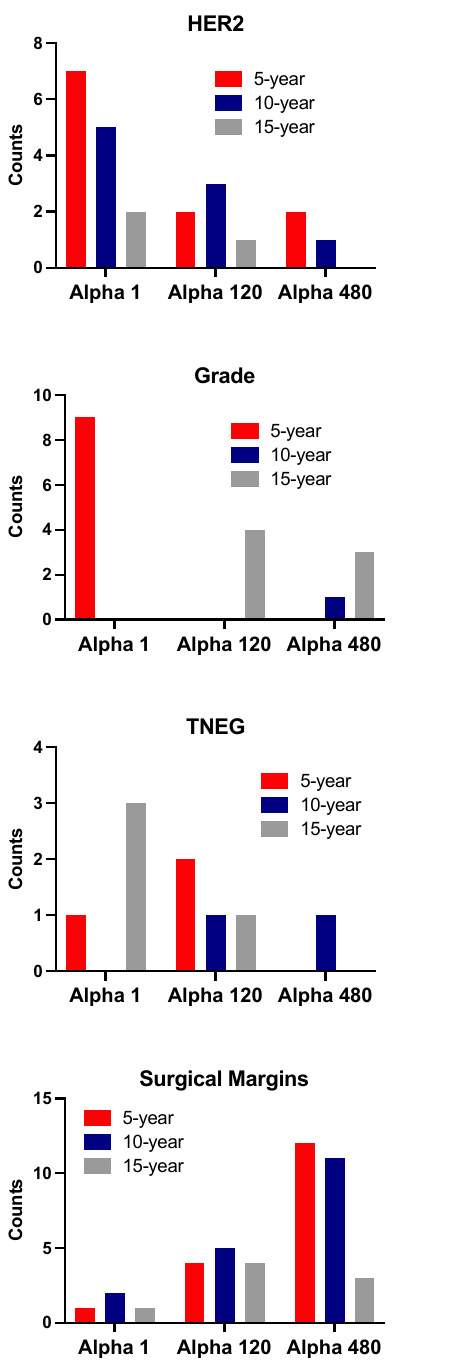
Figure 3. The MBIL generated an output of clinical interactions related to 5-, 10- and 15-year breast cancer metastases. HER2, ER, grade, race/ethnicity, TNEG, smoking/alcohol and surgical margins are represented. Each bar plot indicates the number of counts in which each of these variables was identified as a risk factor of metastasis at different values of alpha.